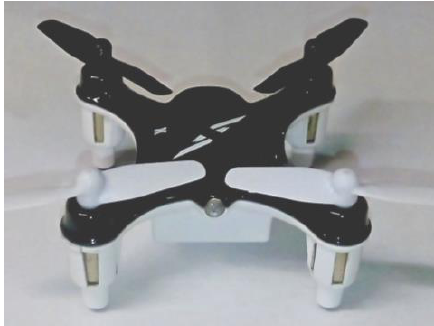
Fig. 1. A quadrocopter Syma